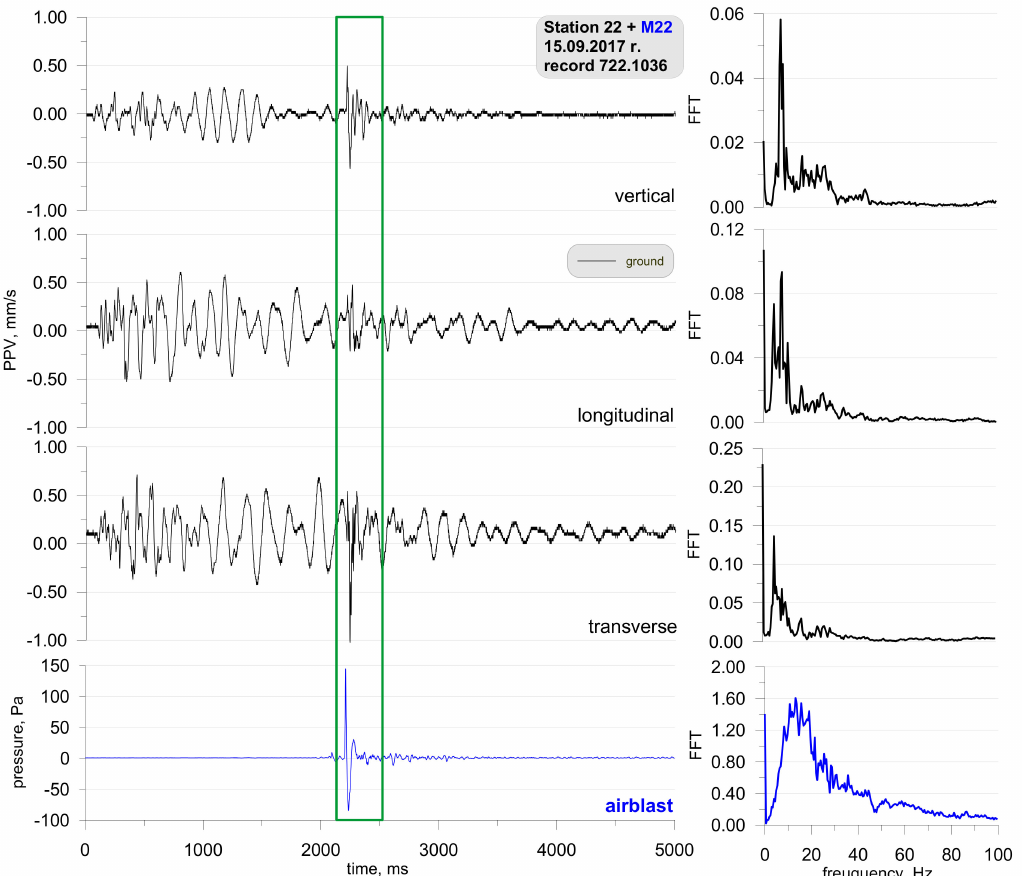
Figure 6. Ground vibration seismogram (three directional components) and recordings of airblast wave pressure combined with the analysis of the FFT-Station 22.